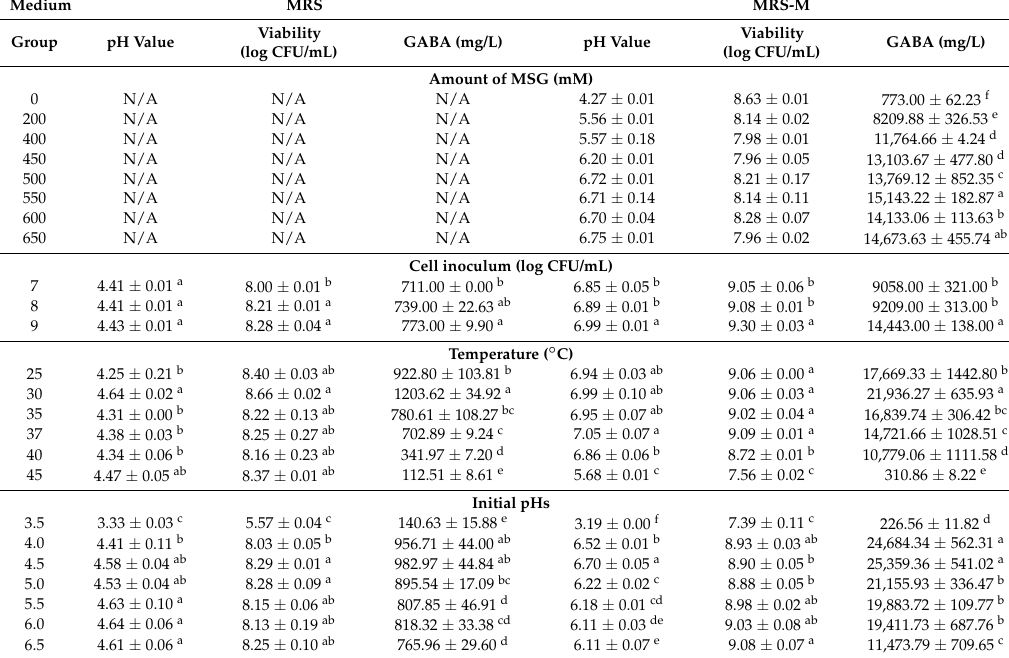
Table 1. The effect of γ -aminobutyric acid (GABA) production by L. brevis RK3 grown in Man, Rogosa and Sharpe (MRS) medium with or without monosodium glutamate (MSG) at different initial inoculum cells, temperature, and pH